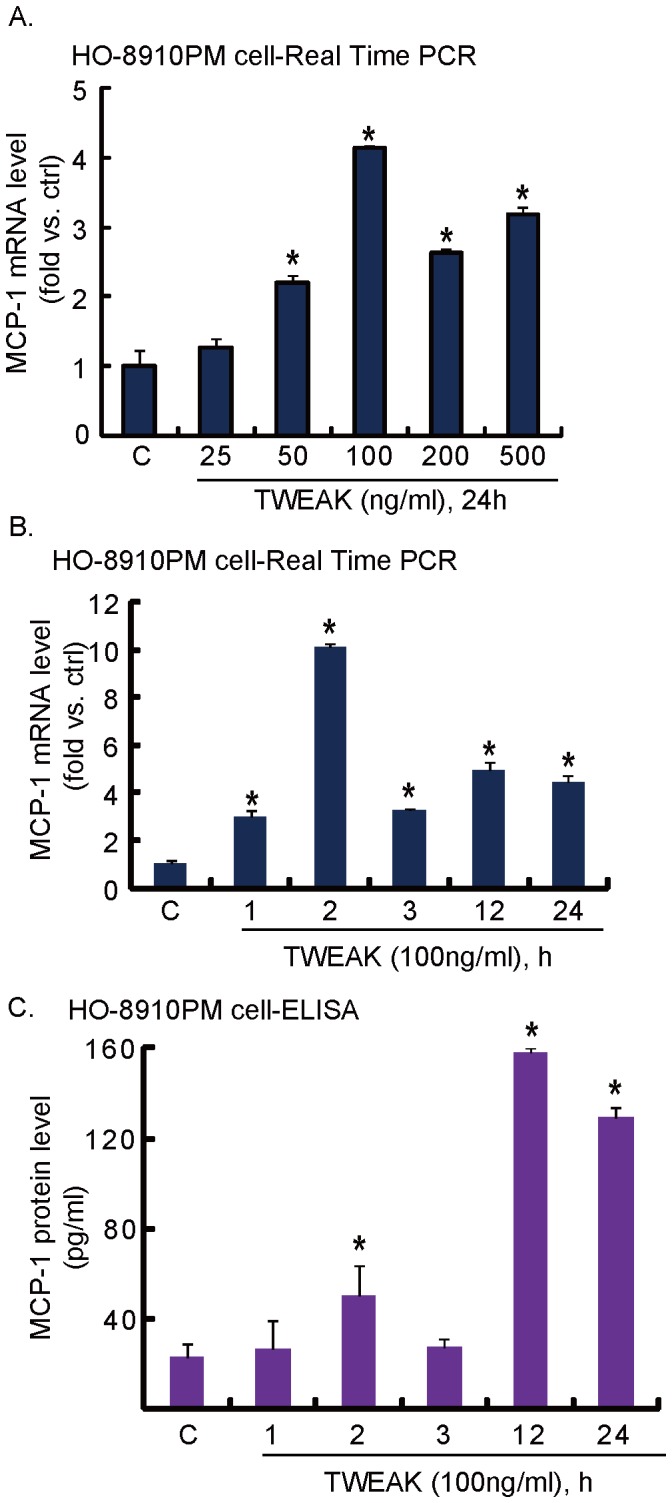
TWEAK induces MCP-1 production in cultured HO-8910PM cells.
(A–B) TWEAK increases MCP-1 mRNA levels in cultured HO-8910PM cells. Cultured HO-8910PM cells were either left untreated (“C”) or treated with various concentration of TWEAK (25, 50, 100, 200 and 500 ng/ml) for 24 hours (A), or treated with 100 ng/ml of TWEAK and cultured for various time points (1 h, 2 h, 3 h, 12 h and 24 h) (B), MCP-1 mRNA was analyzed by real time PCR, and the value was normalized to untreated group. *p<0.05 vs. group “C”. (C) TWEAK increases MCP-1 protein secretion in cultured HO-8910PM cells. Cultured HO-8910PM cells were either left untreated (“C”) or treated with 100 ng/ml of TWEAK and cultured for various time points (1 h, 2 h, 3 h, 12 h and 24 h), concentration of MCP-1 (pg/ml) in culture medium was determined by ELISA assay. *p<0.05 vs. group “C”.